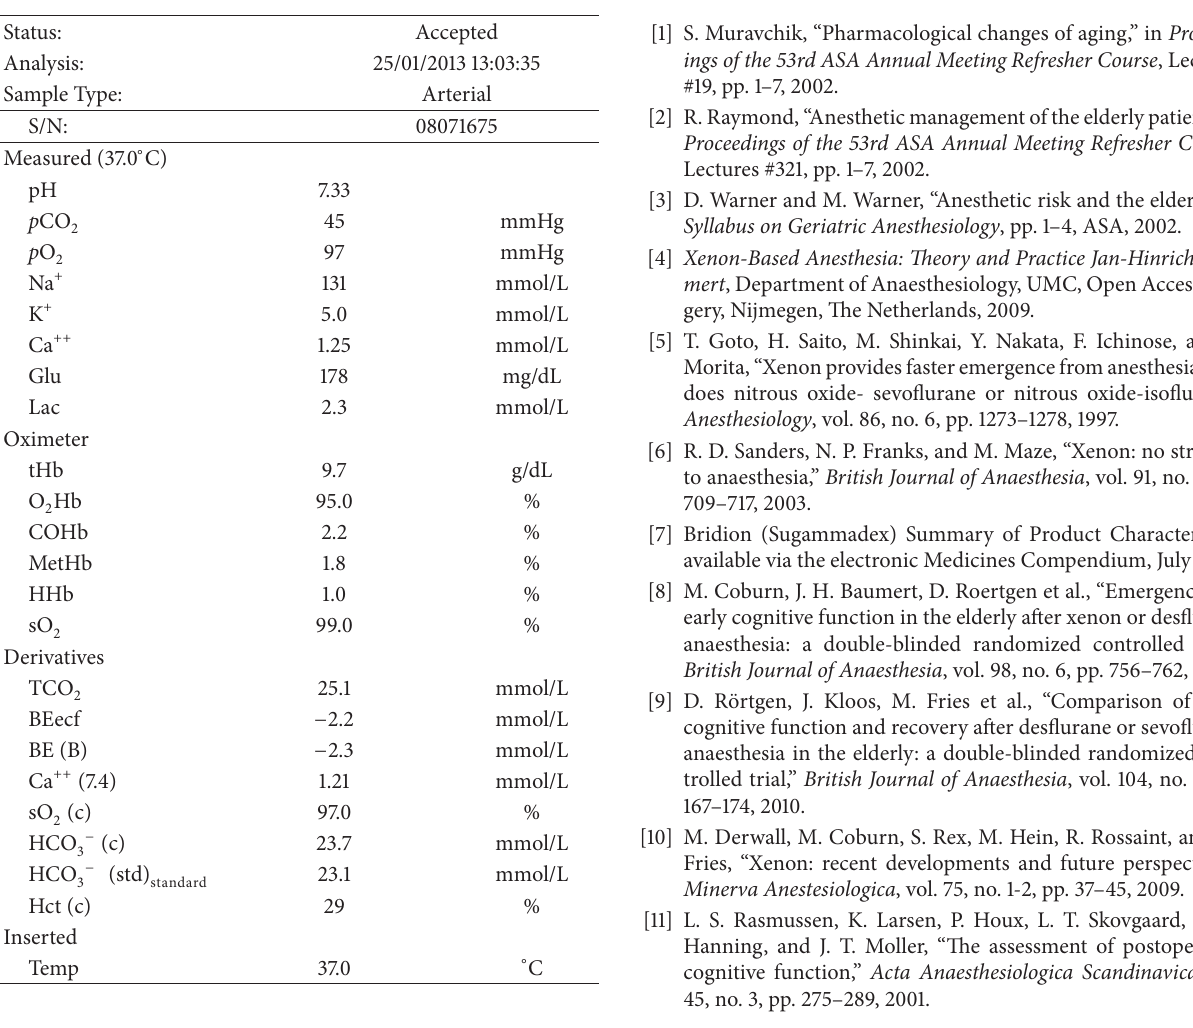
Table 2: Hemogasanalysis 30 minutes after the end of the surgery.